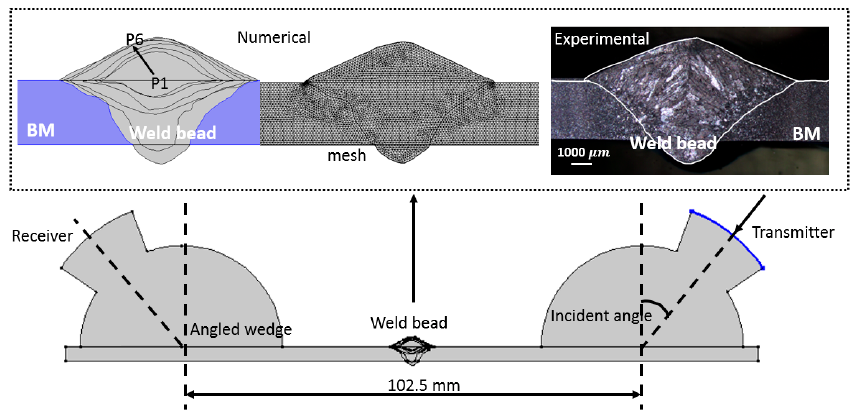
Figure 4. The schematic of the numerical model, (BM: Base Metal). Table 3. Materials’ properties (based on ASTM A1008/A1008M [21]) used in the numerical models.